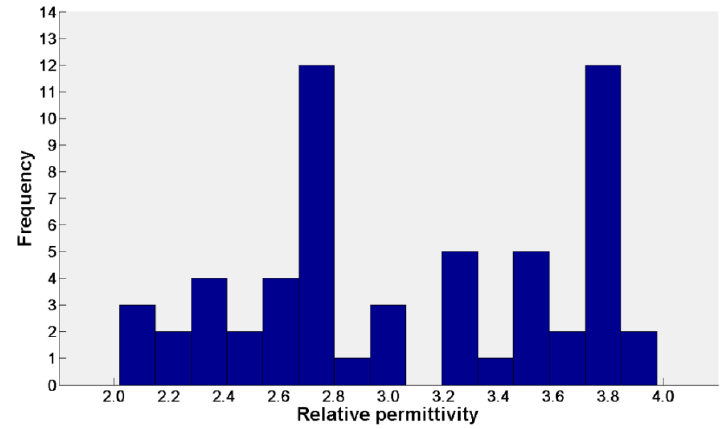
Figure 14. The reflection wavelet waveform of an abnormal body in LPR data.